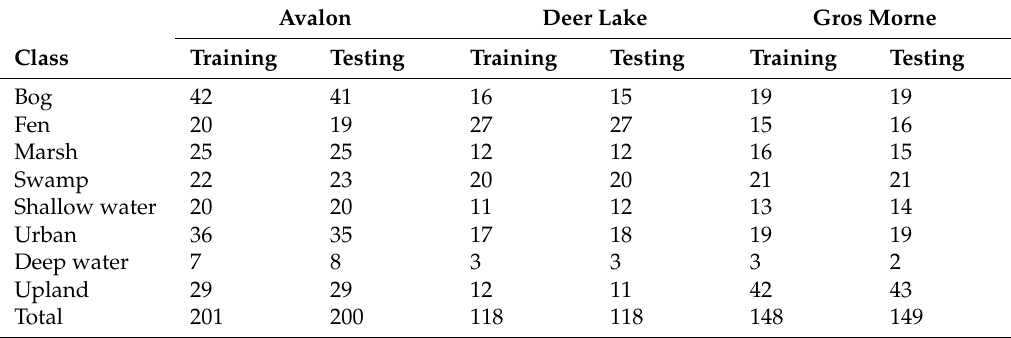
Table 1. Number of training and testing polygons for each class in the three pilot sites.